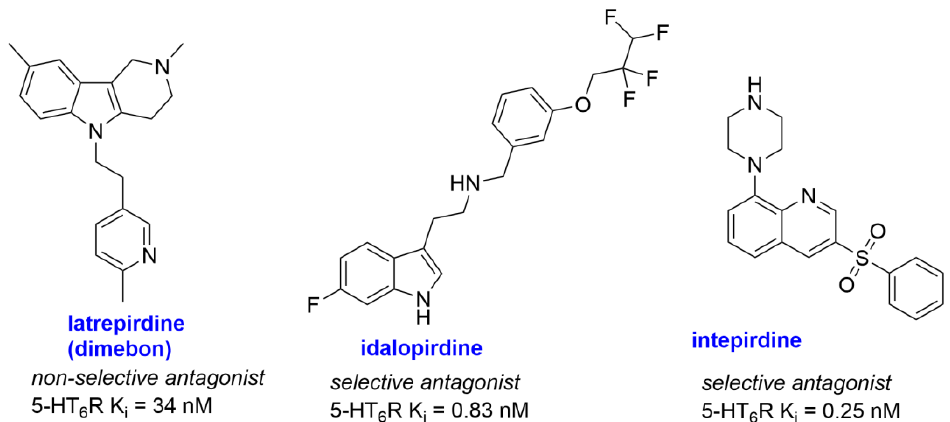
Figure 1. Structure and 5-HT 6 receptor affinity of compounds that reached phase III. Data from [8]. 5-HT 6 R is found almost exclusively in the central nervous system, where it particu- larly moderates GABA and glutamate levels and facilitates the release of neurotransmit- ters such as dopamine, norepinephrine and acetylcholine, all of which are compromised